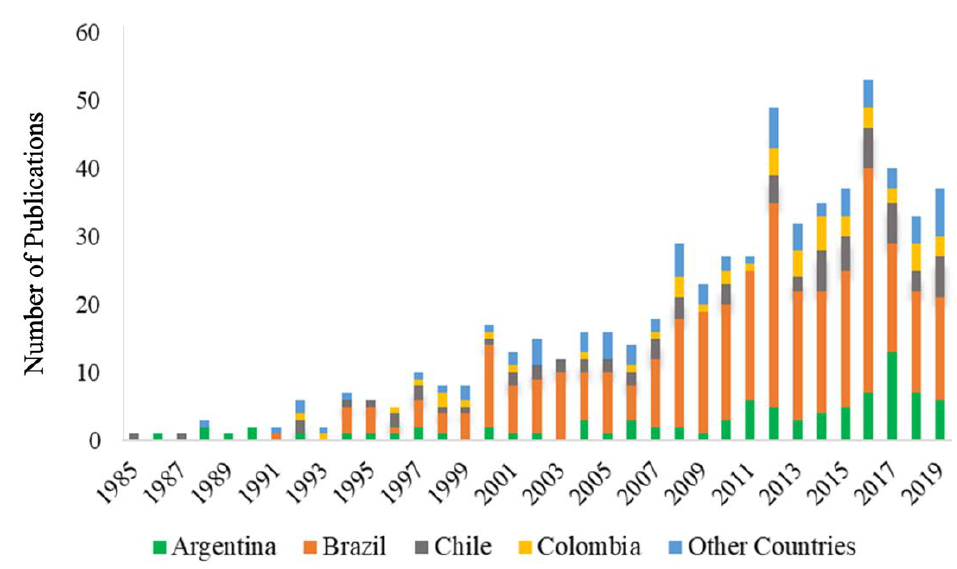
Figure 2. Number of publications by country of concentrations of endocrine disruptors evaluated in tissue.